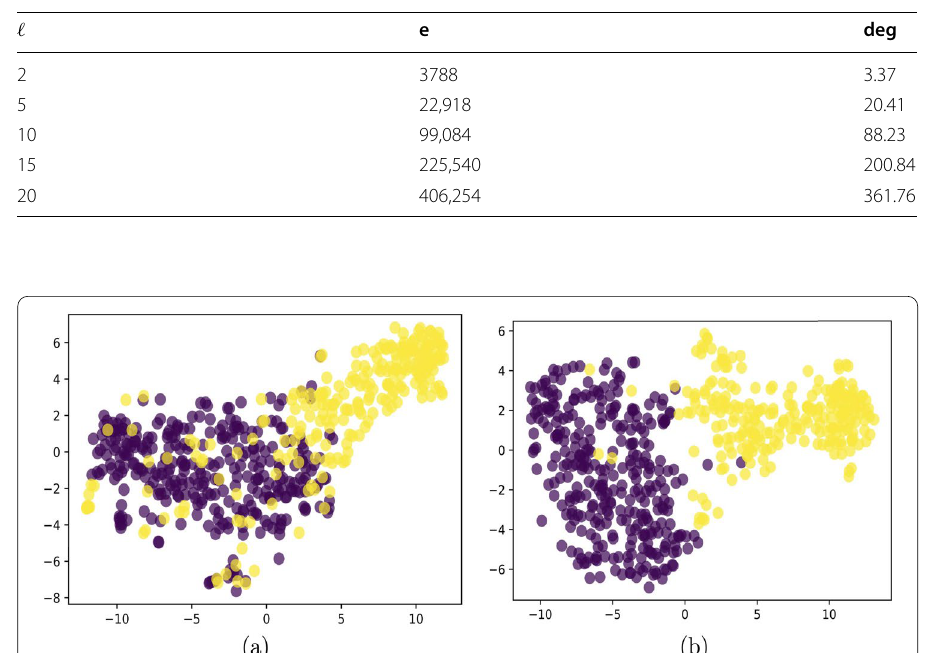
Table 4 Inter-layer edge information of Koumbia multilayer networks for different number of layers (Interdonato et al. 2020): number of inter-layer edges (e), inter-layer average degree (deg)